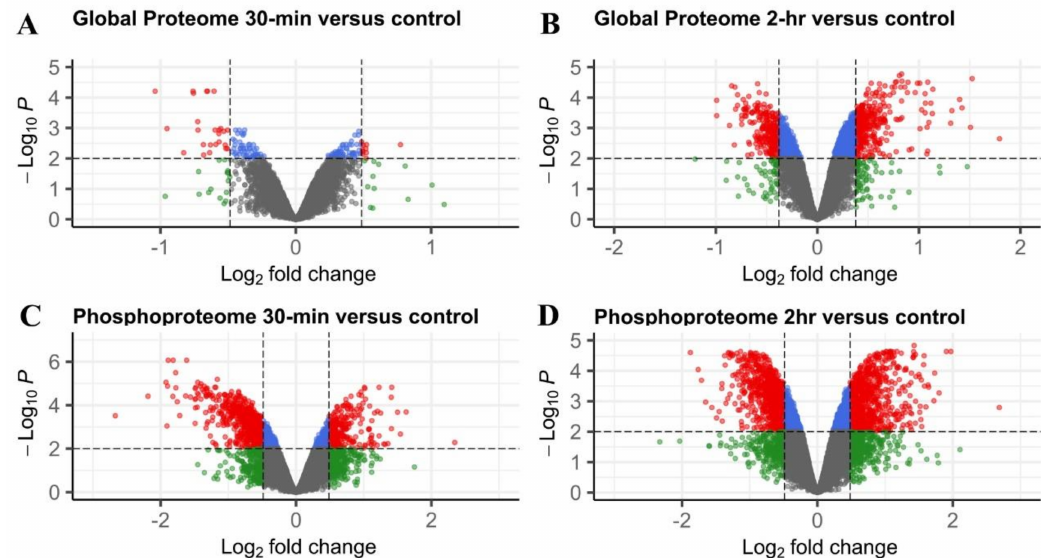
Figure 3. Volcano plot visualization of cold-responsive proteins ( A , B ) and phosphopeptides ( C , D ) un- der 30 min ( A , C ) or 2 h ( B , D ) of cold treatment. Cold-responsive proteins or phosphopeptides are depicted in red. X-axis is the Log2 of fold change (treatment /control) and Y-axis is the negative Log10 of the p value for independent t-test adjusted by the Benjamini–Hochberg procedure. Vertical dashed lines denote a fold change cutoff in either direction. The horizontal dashed line represents a cutoff of an adjusted p value of 0.01.